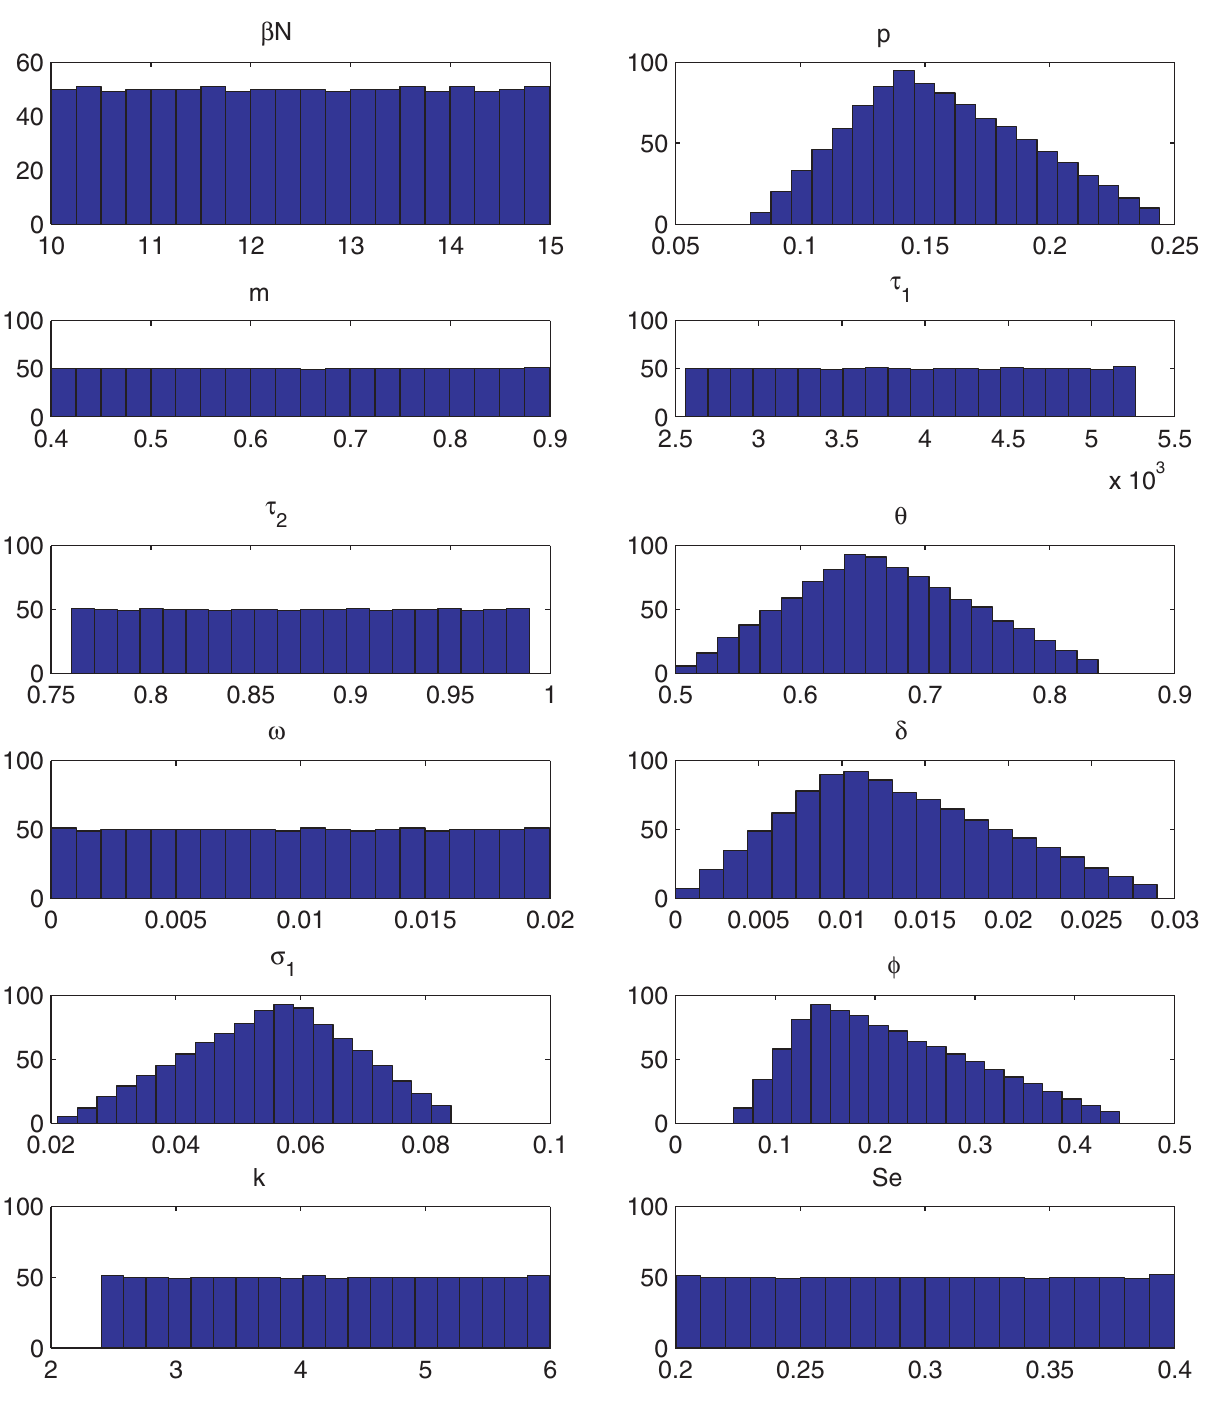
Figure 3. Histograms of the twelve parameters in the sample generated with LHS method.